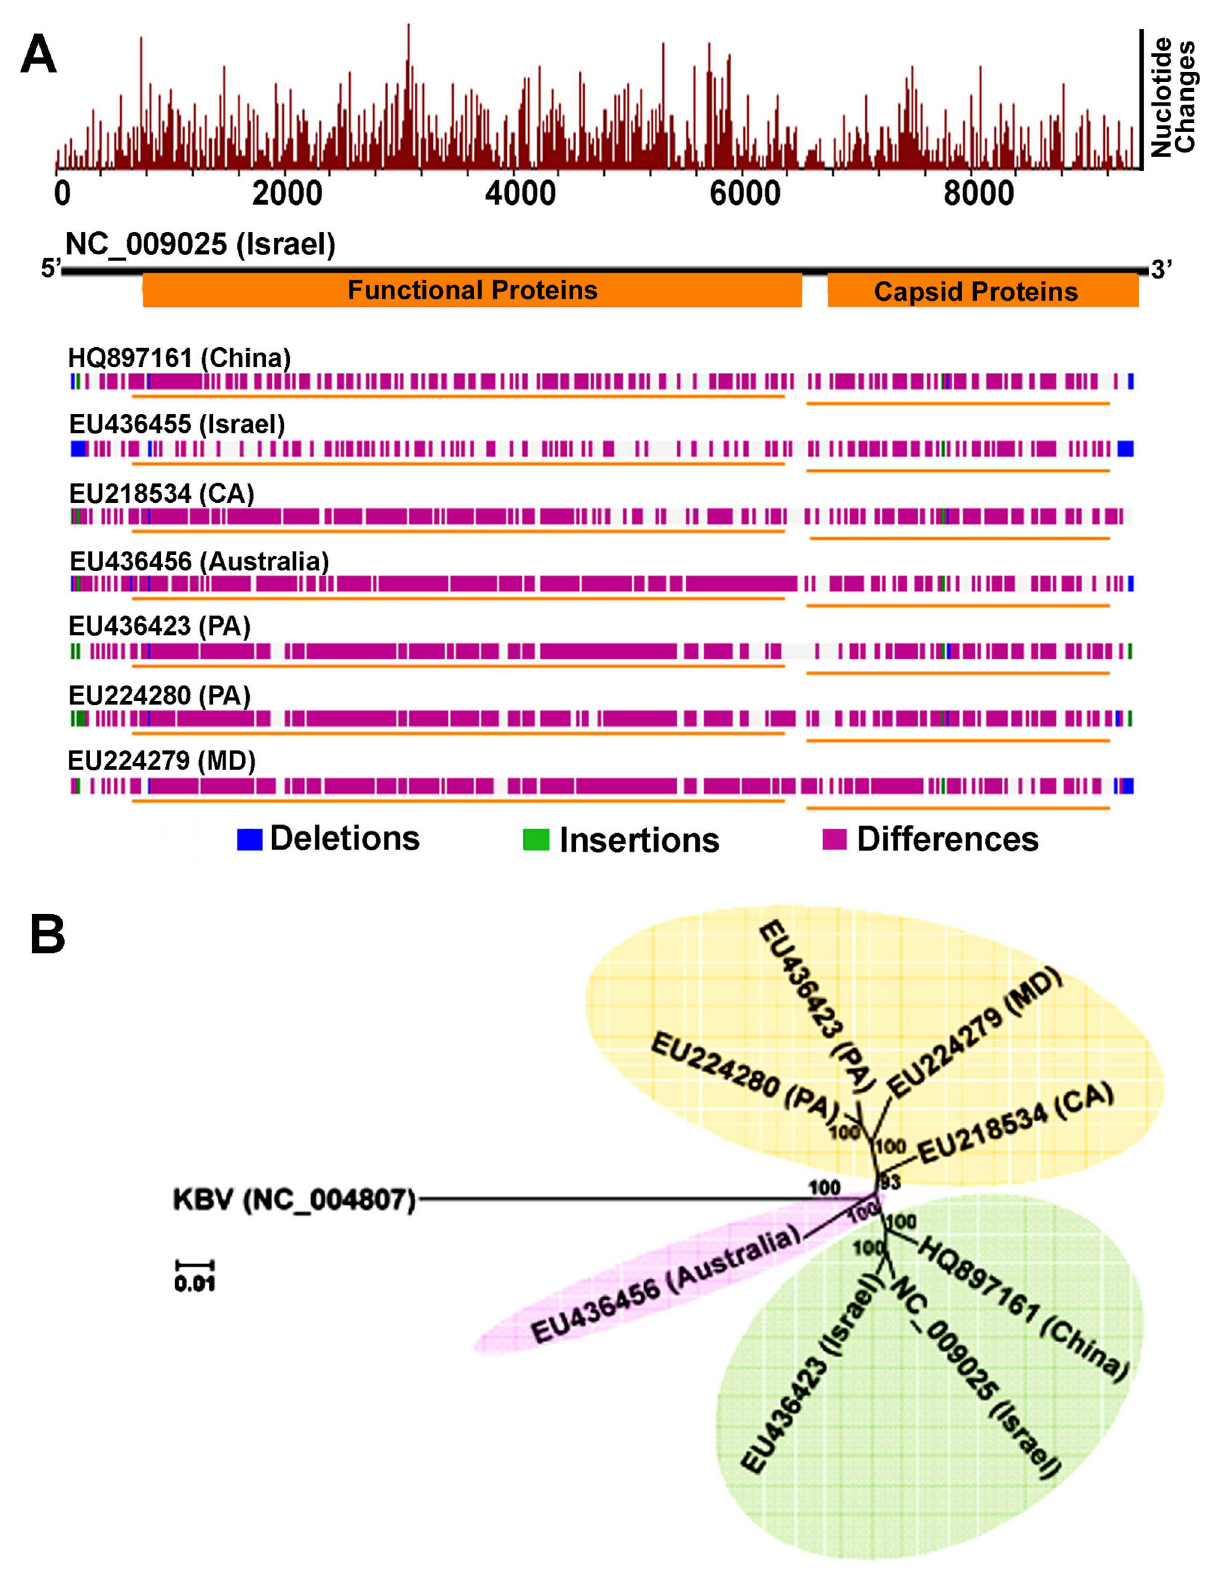
Figure 4. Genome-wide sequence diversity and phylogenetic relationship of IAPV isolates. ( A ) A graphical representation of the pair-wise global alignments of the reference sequence of IAPV (NC_009025), the first complete sequence of IAPV, with other IAPV genome sequences individually. This figure is retrieved from GenBank and modified. The alignments were pre-computed using the ‘‘band’’ version of the Needleman- Wunsch algorithm. The top histogram shows the average density of nucleotide changes (excluding gaps, insertions and undetermined nucleotides)